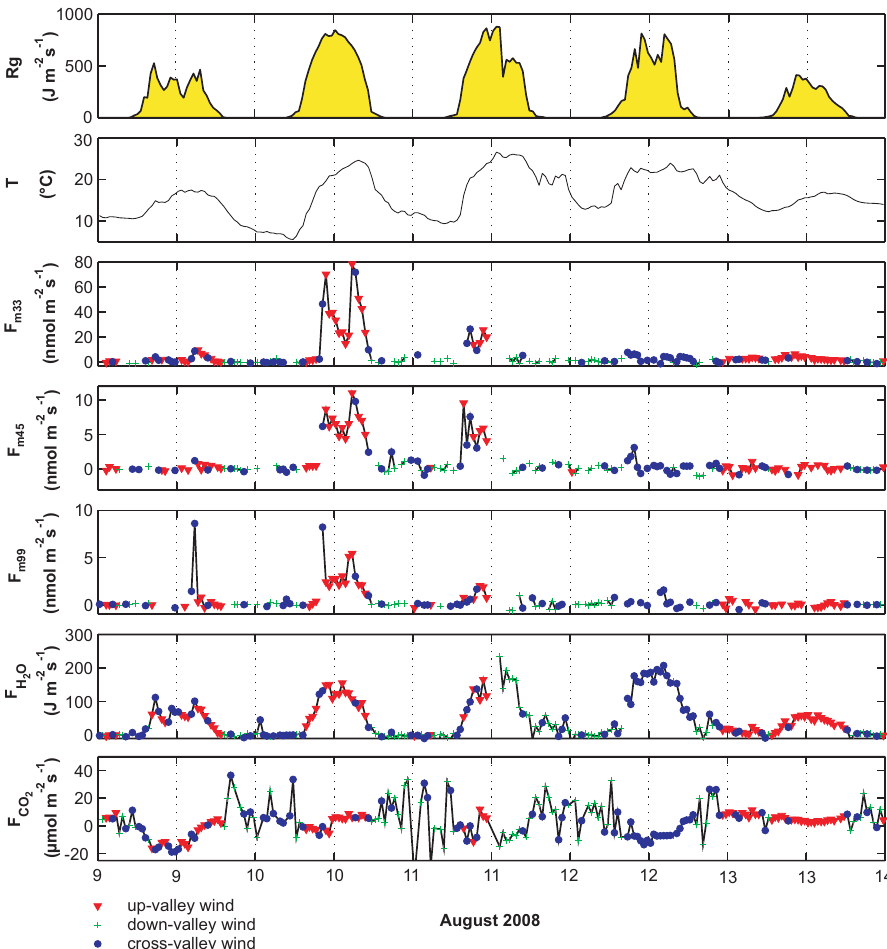
Fig. 7. From the upper panels to the lower: Time series of the global radiation (Rg), temperature, methanol flux, acetaldehyde flux, flux m/z 99, latent heat flux and CO 2 flux during the second hay harvest on the 10th of August 2008.